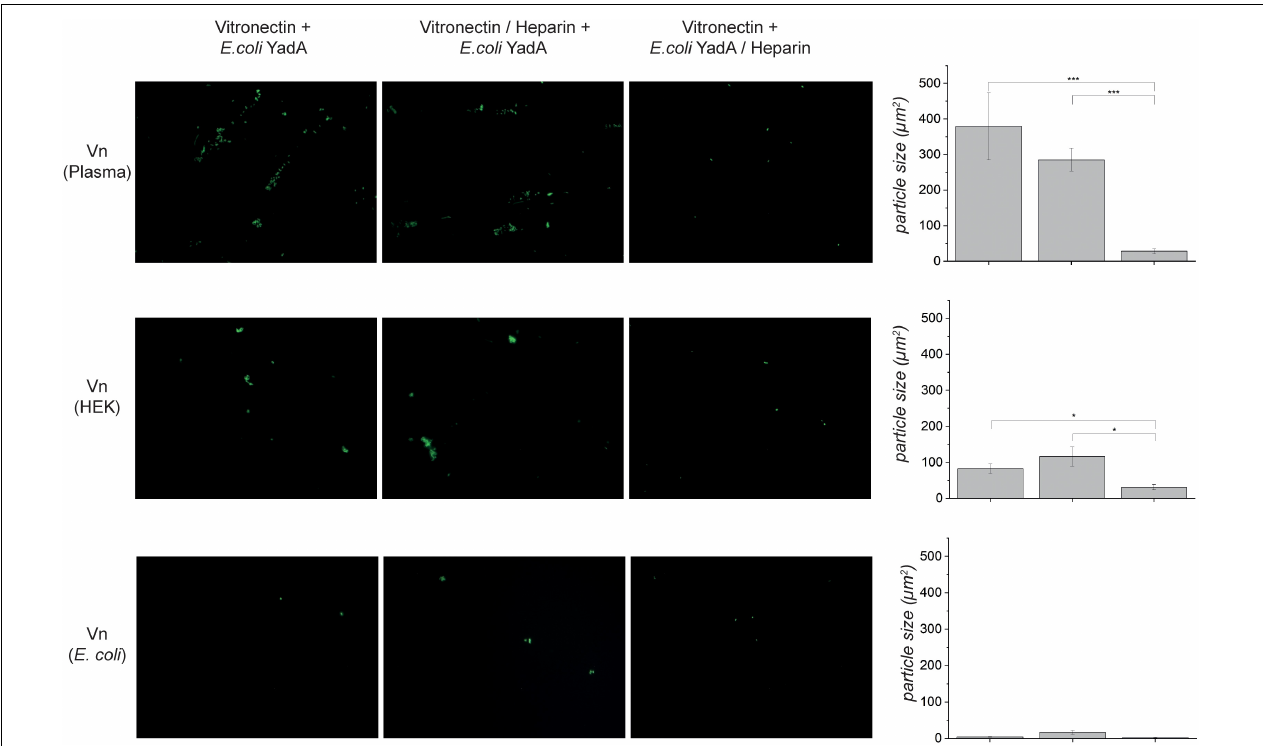
FIGURE 3 | Binding of E. coli expressing YadA O : 9 is reduced when the bacteria are preincubated with heparin-disaccharide. Vn from different sources was coated onto coverslips, and binding of fluorescence E. coli expressing YadA O : 9 was measured (left column). Images in the middle column show micrographs of Vn-coated coverslips that were preincubated with 100 µ M heparin-disaccharide. Afterward, binding of fluorescent E. coli expressing YadA O : 9 was monitored. When Vn was coated and binding of fluorescent E. coli expressing YadA O : 9 that were preincubated with heparin was (column 3) reduced, adhesion was measured for both Vn plasma and Vn HEK . E. coli expressing YadA O : 9 did only weakly bind to Vn Ec as already observed in previous experiments. In the last column, the mean area of particles ( µ m 2 ) ± SEM was calculated and plotted as bar graphs. Significance levels are indicated with * p < 0.05, ** p < 0.01, *** p <